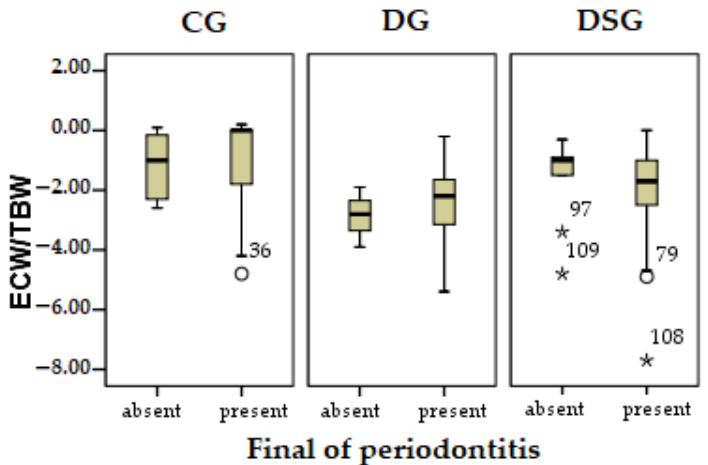
Figure 7. Evolution of the correlation of fat mass with periodontopathogens at the end of the study in the three research groups.